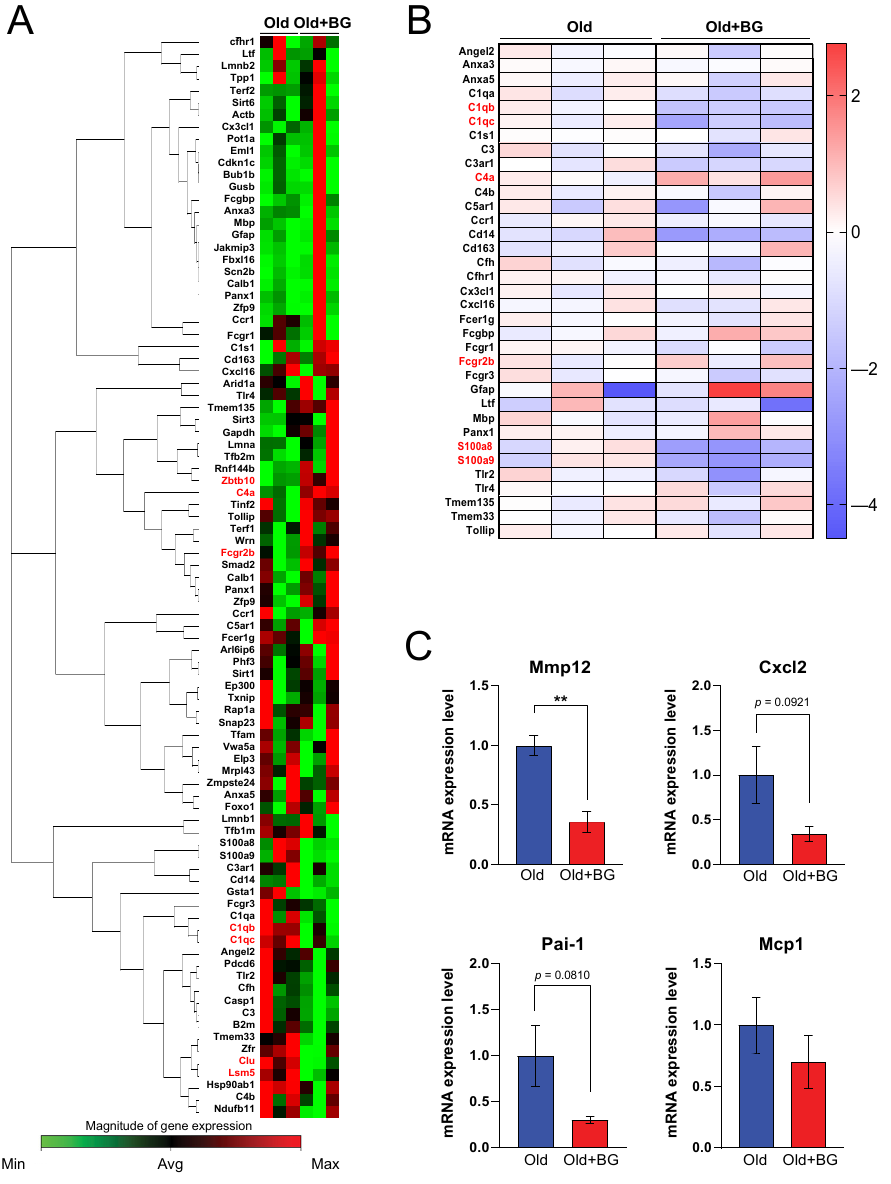
Figure 2. Clustergram ( A ) of aging-associated genes, heat map ( B ) of inflammation-related genes, and mRNA expression level ( C ) of SASP factor genes ( Mmp12, Cxcl2, Pai-1, Mcp1 ) in liver isolated from Old or Old+BG mice (n = 3). ** p ≤ 0.01.